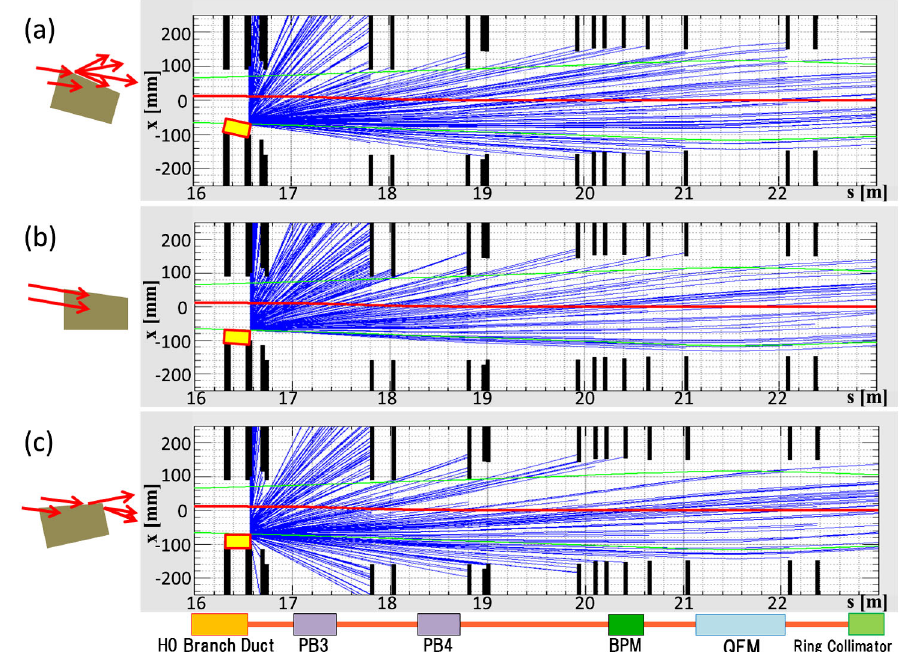
FIG. 7. Tracking of the particles leaking from the absorber between the absorber and the ring collimator: (a) rotated 1 (cid:4) toward the beam center; (b) no rotation; (c) rotated 1 (cid:4) away from the beam center. dependence with respect to rotation at the inside of the BPM could be determined. This loss dependence is shown in the right-hand part of Fig. 8 and can be explained as follows. Because the axis of rotation of the absorber is downstream, the inner edge downstream of the absorber is nearly fixed. In case 2 of Fig. 8, the scattered particles and the beam side of the absorber are parallel. In case 1, the loss decreases in comparison with that of case 2, because the upstream edge of the absorber approaches the beam